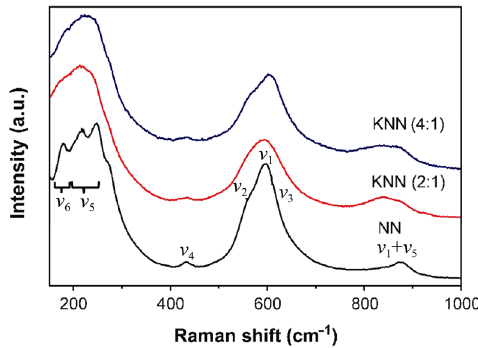
Fig. 6 Raman spectra of NaNbO 3 structures and KNN structures with KCl/NaCl ratios of 4/1 and 2/1.